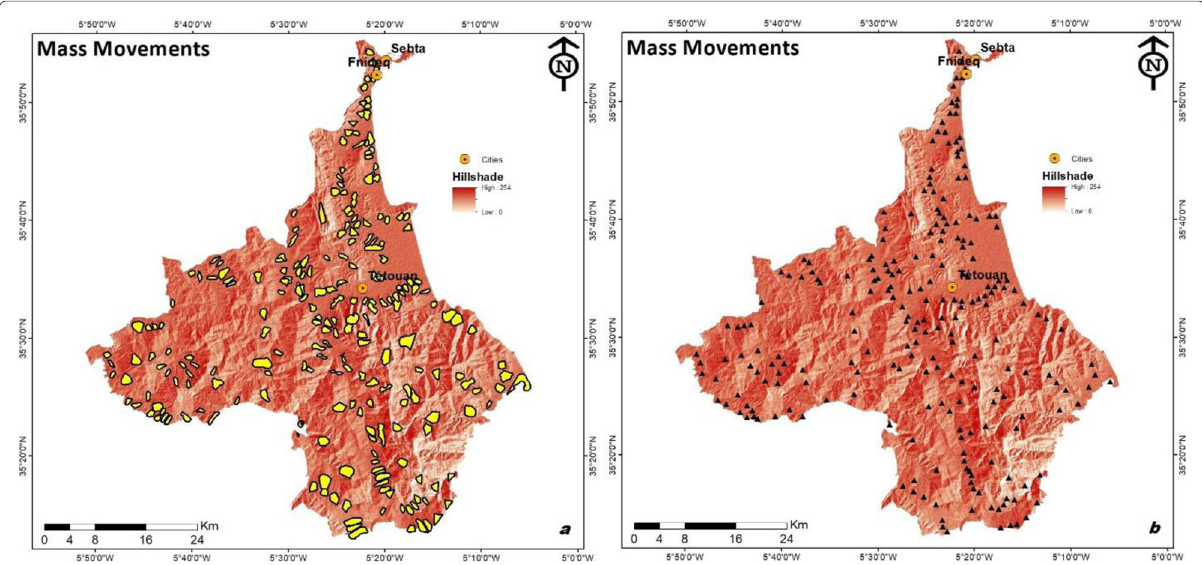
Fig. 4 Mass movements of Tétouan province in polygon-shaped ( a ) and in form of centroids ( b